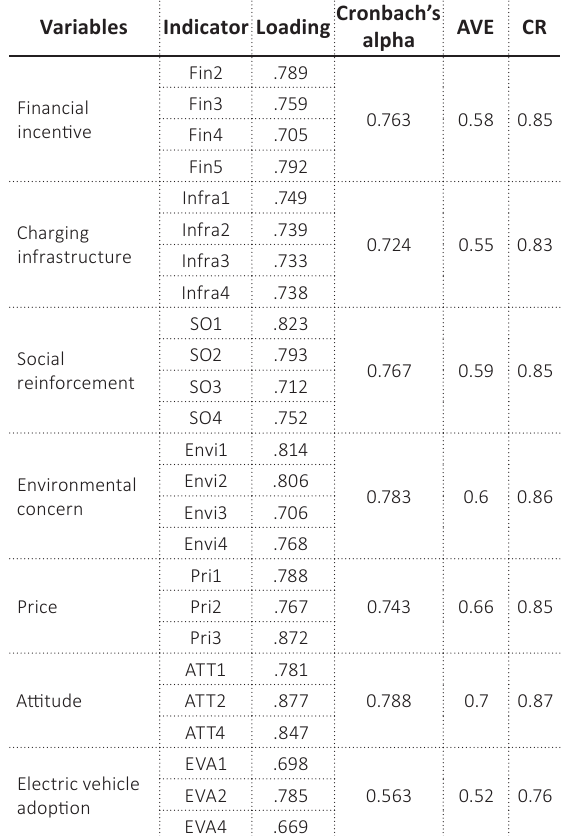
Table 3. Reliability and validity